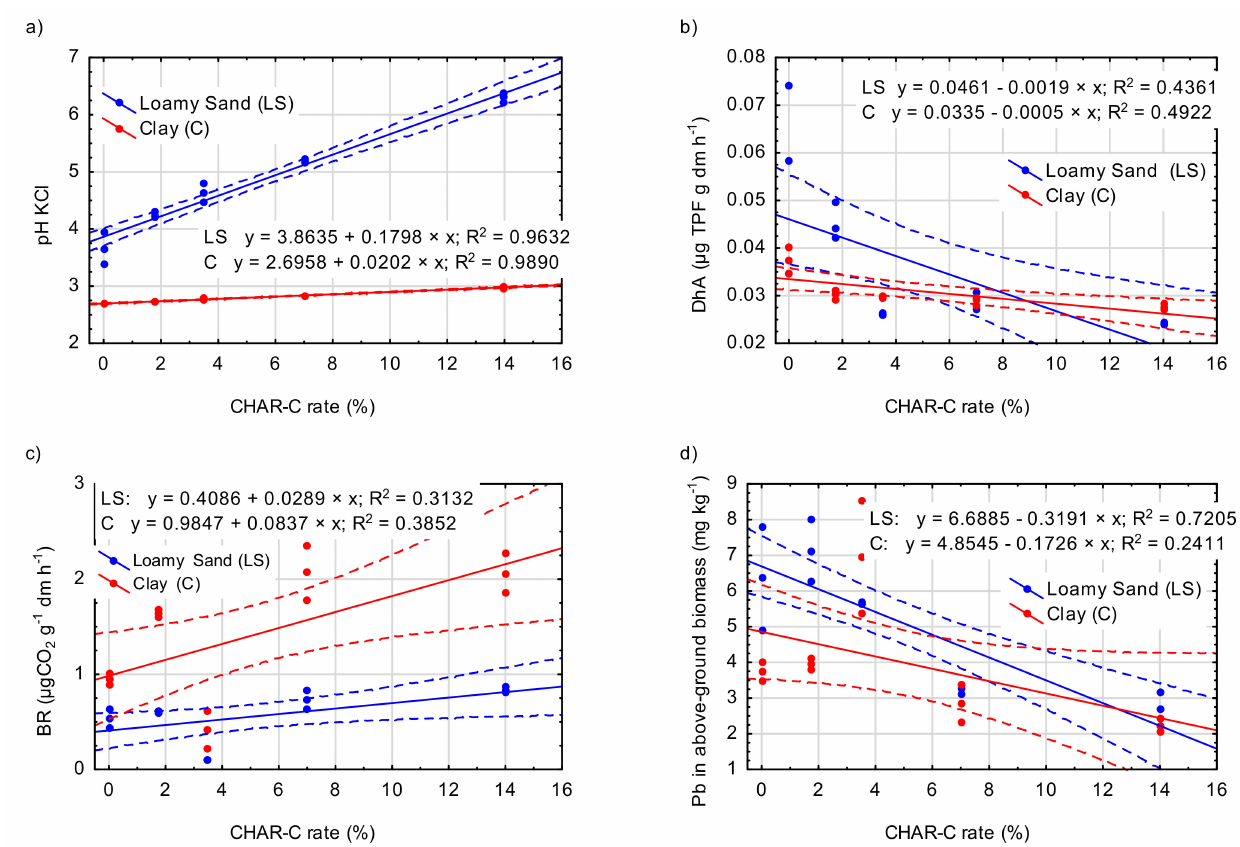
Figure 5. Relationship between the CHAR-C rate and chemical properties of soil: pH KCl ( a ), DhA ( b ), BR ( c ) and Pb in aboveground biomass ( d ). The solid line is the fitted linear regression, and the dotted lines represent the 0.95 confidence in-